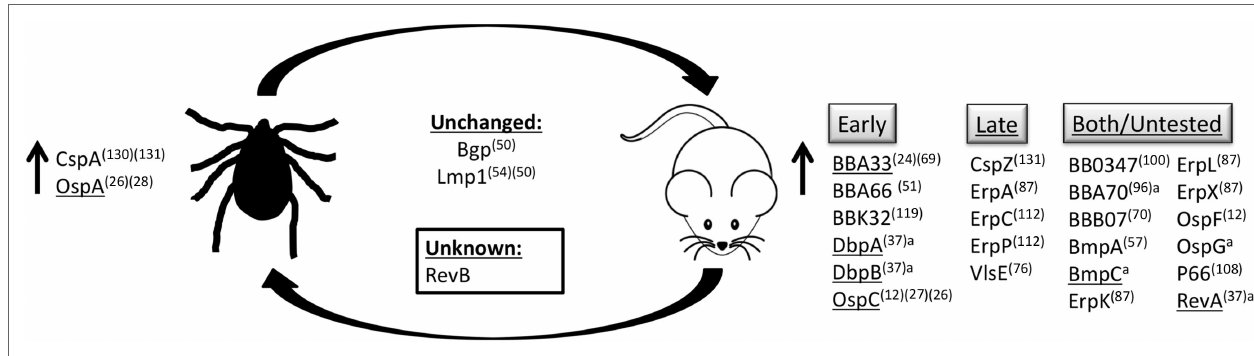
FiGURe 1 | Outer surface protein regulation . B. burgdorferi senses changes in temperature, pH, and cell density, as well as unknown stimuli to modulate production of proteins on the bacterial surface. Proteins listed are upregulated in their respective environments, in the tick vector or the mammalian host, or are produced at similar levels in both environments. Proteins produced during mammalian infection are grouped based on temporal expression pattern, expressed early during infection (early), during persistent infection (late), or those that have been detected both early and late during infection or have not been experimentally determined (both/untested). a Based on in vivo qRT-PCR and microarray data (15). (#) Reference. Underline indicates genes regulated by the RpoS regulon.